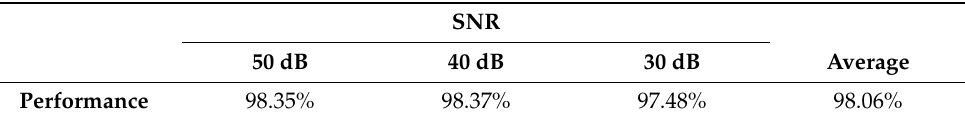
Table 3. Resulting classification accuracy at different SNR.